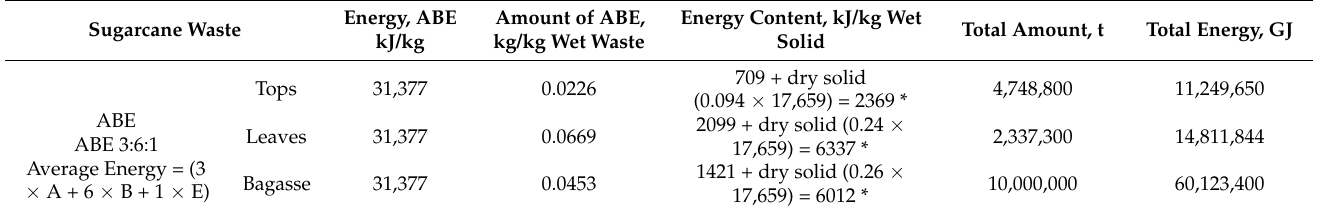
Table 17. Energy production from wet trash and bagasse compared to ABE-trash/bagasse